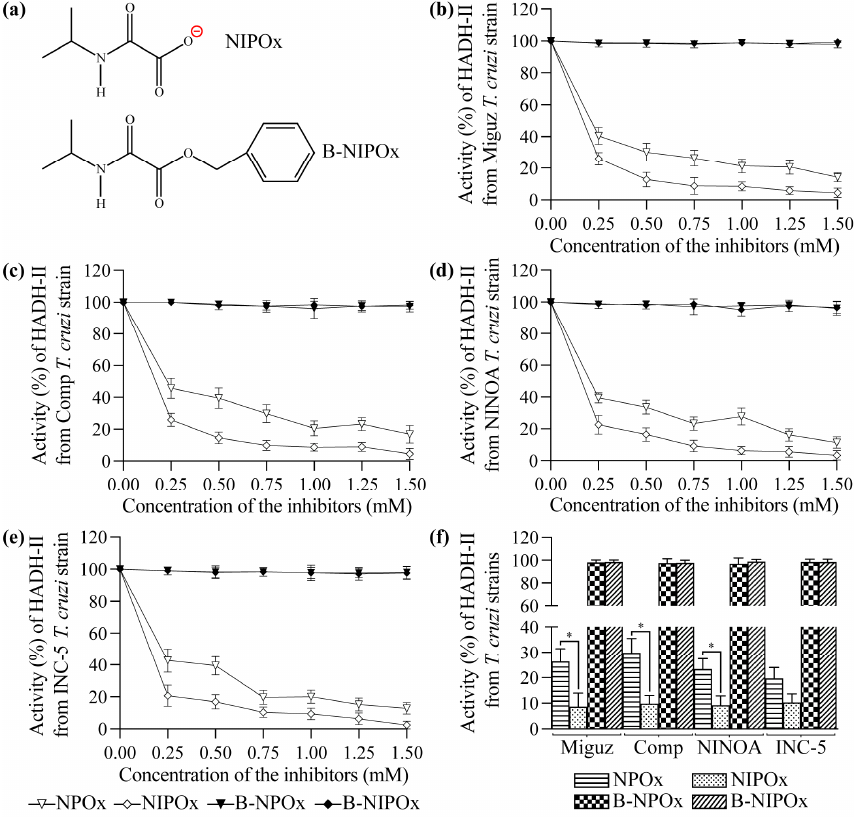
Figure 1. N-isopropyl oxamic acid (NIPOx) is a better inhibitor of the α -hydroxy acid dehydrogenase isozyme II (HADH-II) from Trypanosoma cruzi than N-propyl oxamic acid (NPOx). ( a ) Structure of NIPOx (HADH-II inhibitor) and its benzyl ester (B-NIPOx). The inhibition activity of NPOx, NIPOx, B-NPOx and B-NIPOx over the purified HADH-II from ( b ) Miguz, ( c ) Compostela (Comp), ( d ) NINOA and ( e ) INC-5 T. cruzi strains were analyzed in the presence of 0.12 mM NADH + + H + and 5 mM α -ketoisocaproate. The inhibitors were evaluated at concentrations of 0.25, 0.50, 0.75, 1.00, 1.25 and 1.50 mM. The HADH-II activity was measured by the changes in the absorption at 340 nm over 5 min and was expressed as a percentage of ∆ E 340 nm/min, where the enzymatic activity in absence of inhibitor was considered 100%. ( f ) Asterisks represent statistically significant differences between the HADH-II activity in the presence of 0.75 mM inhibitors (* p ≤ 0.05). n = 6. One experiment representative of three is